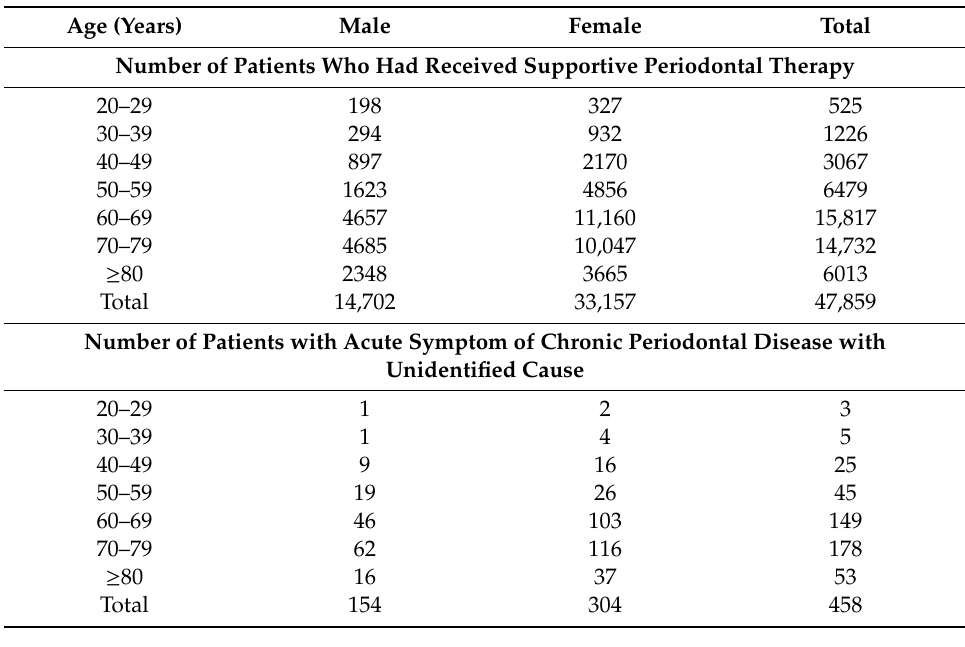
Table 2. Climate predictors of the acute symptom of chronic periodontal disease with unidentified